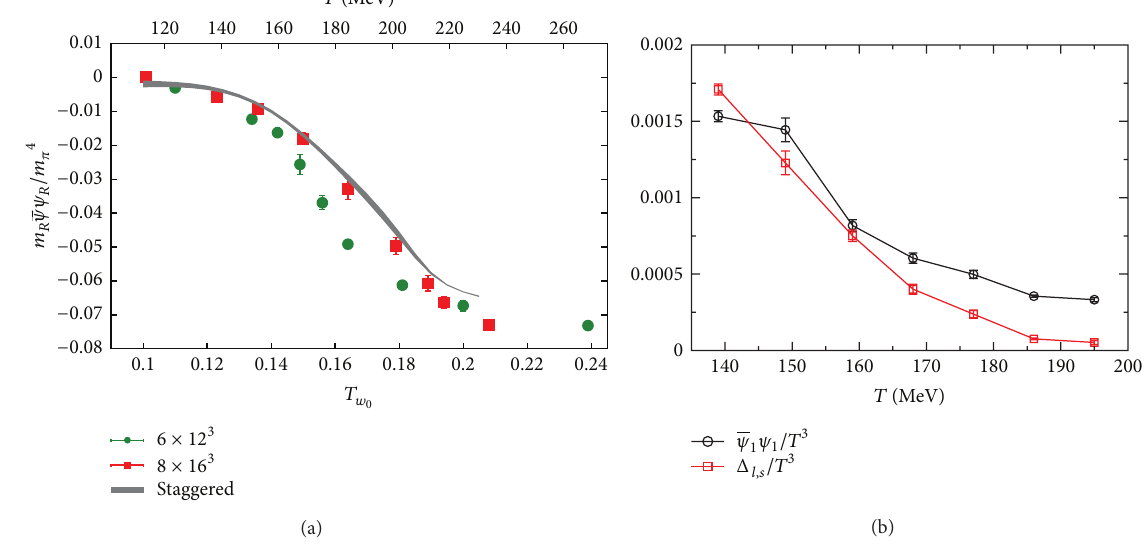
Figure 7: The renormalized chiral condensate for the overlap quarks is compared to the continuum extrapolated results using the stout smeared staggered quarks in (a), from [21]. In (b), the behaviour of different chiral condensates defined using the domain wall fermions is shown in the critical region, from